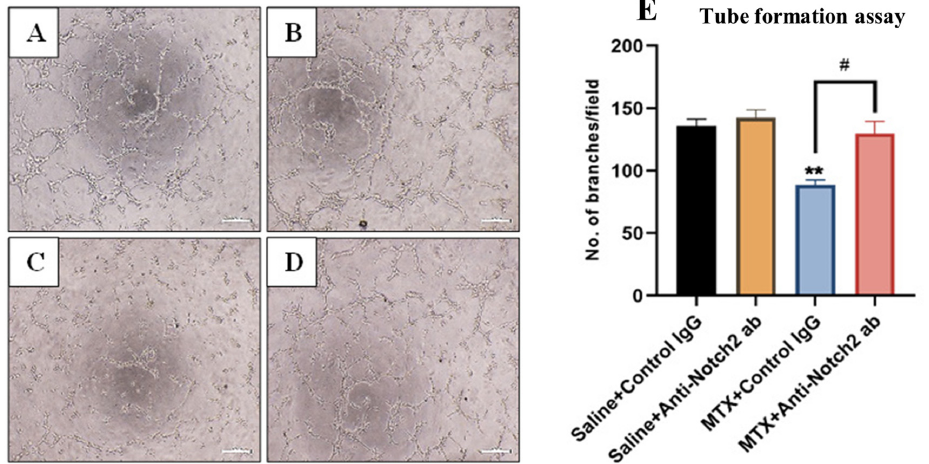
Figure 7. Treatment effects of MTX ± anti-Notch2 antibody (ab) on tube formation ability of rat bone marrow-derived endothelial cells (BMECs). Representative microscopic images of tube for- mation for endothelial cells treated with ( A ) Saline+Control IgG, ( B ) Saline+Anti-Notch2 antibody, ( C ) MTX+Control IgG, and ( D ) MTX+Anti-Notch2 antibody. Scale bar is 200 µ m. ( E ) Average num- bers of branches per field (as mean ± SEM) from three independent experiments. ** p < 0.01 compared to the control IgG group and # p < 0.05 when compared between MTX treatment